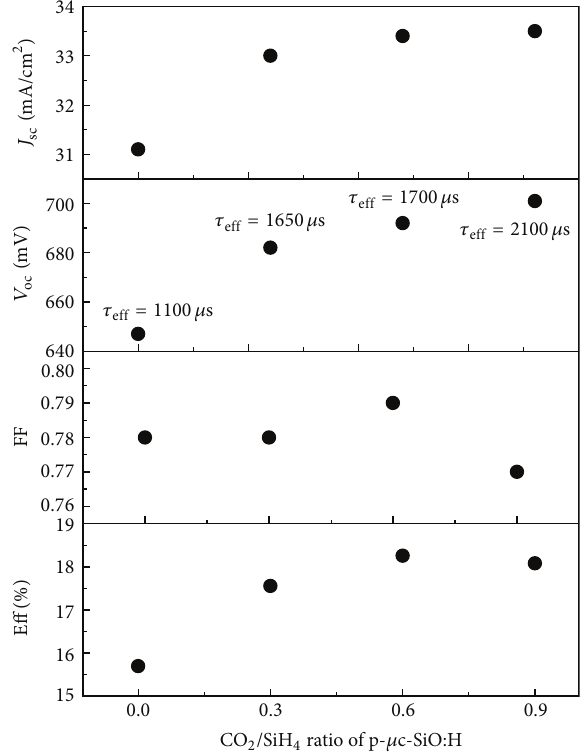
Figure 5: Photovoltaic parameters of the c-Si-HJ solar cells with p- 𝜇 c-SiO:H layers deposited at various CO